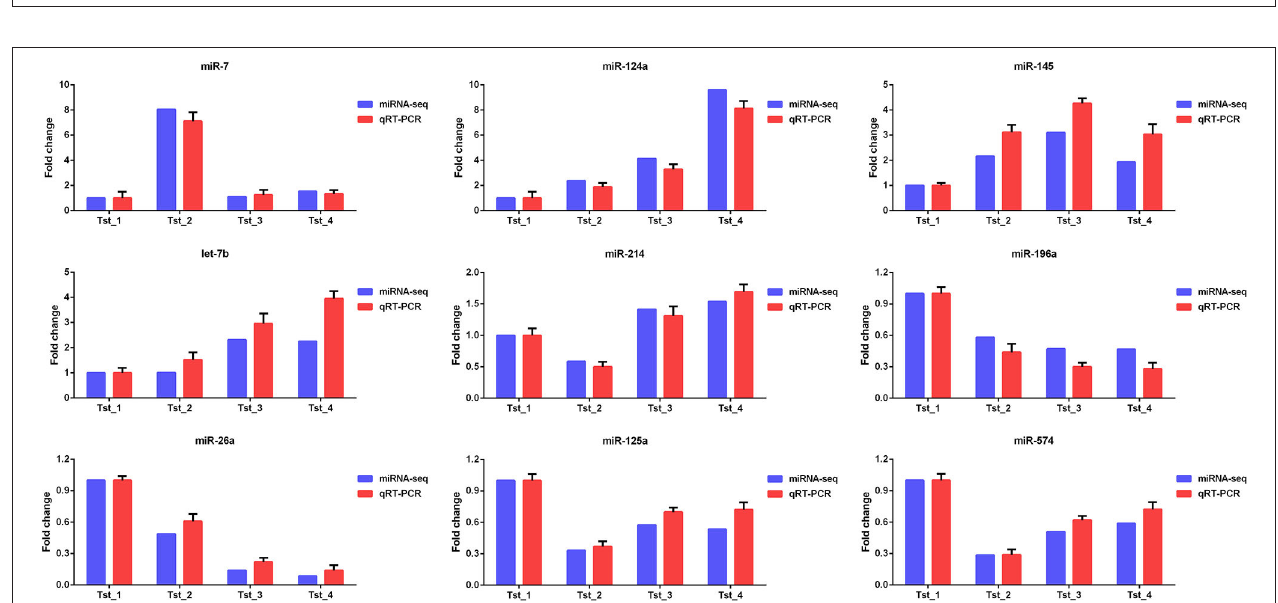
FIGURE 6 | Q-PCR validation of mRNA-seq data.